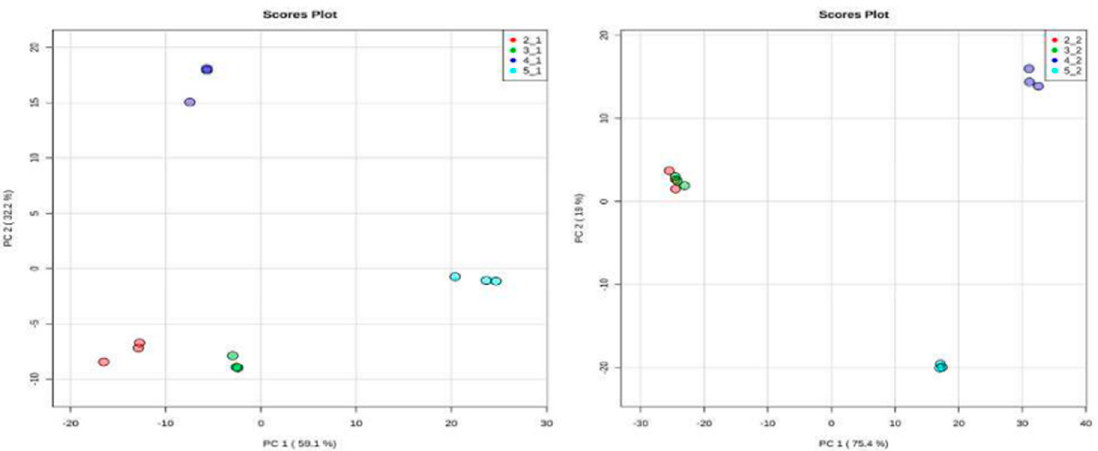
Figure 7. Score plot of 12 samples of organic and aqueous extracts of all manipulation, obtained from 168 ( left ) and 412 ( right ) variables, respectively. (2_1and 2_2) red circle, healthy Allamanda leaves; (3_1and 3_2) green circle, predated Allamanda leaves; (4_1and 4_2) blue circle, caterpillar bodies and (5_1and 5_2) light blue circle, caterpillar feces.